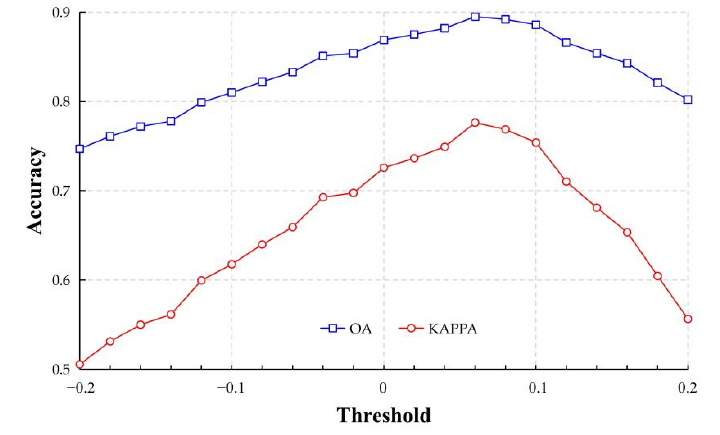
Figure 8. Overall accuracies and Kappa coefficients using different thresholds.